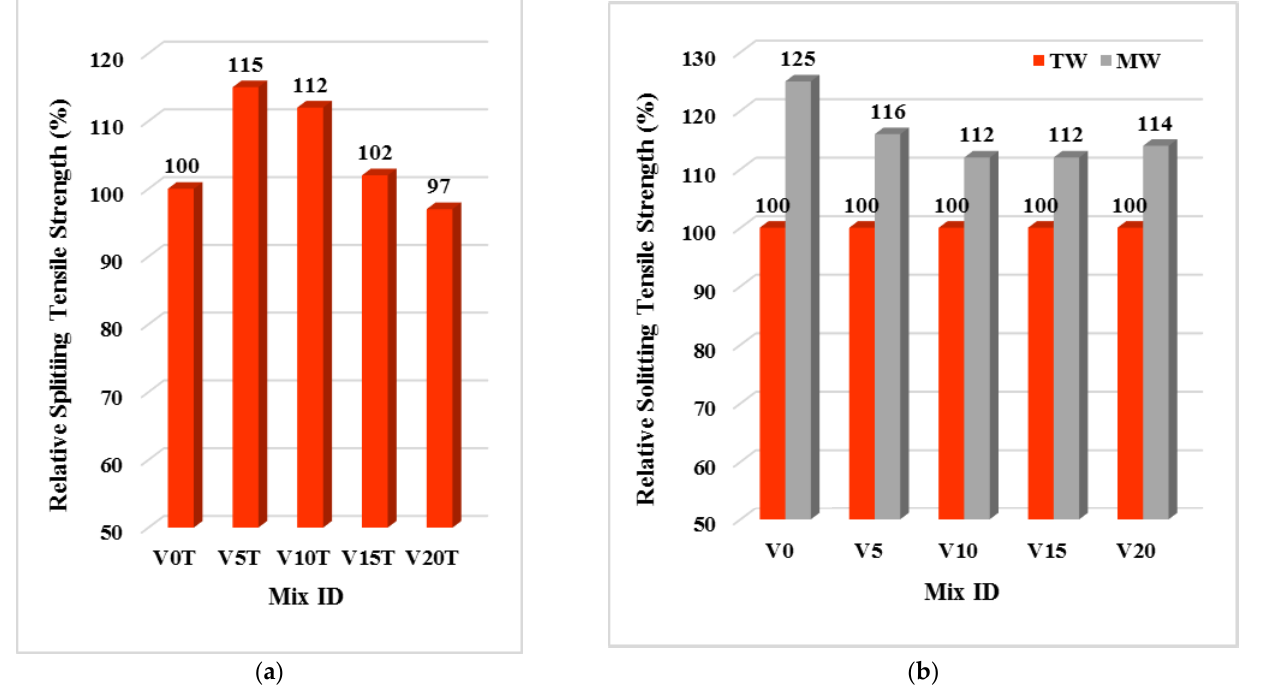
Figure 13. Volcanic concrete splitting tensile strength: ( a ) effect of VA and ( b ) effect of MW.